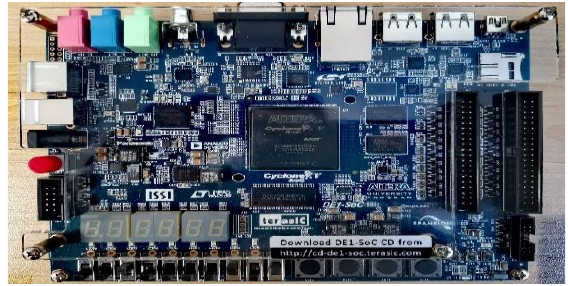
Fig. 1 . DE1-SoC development board (top